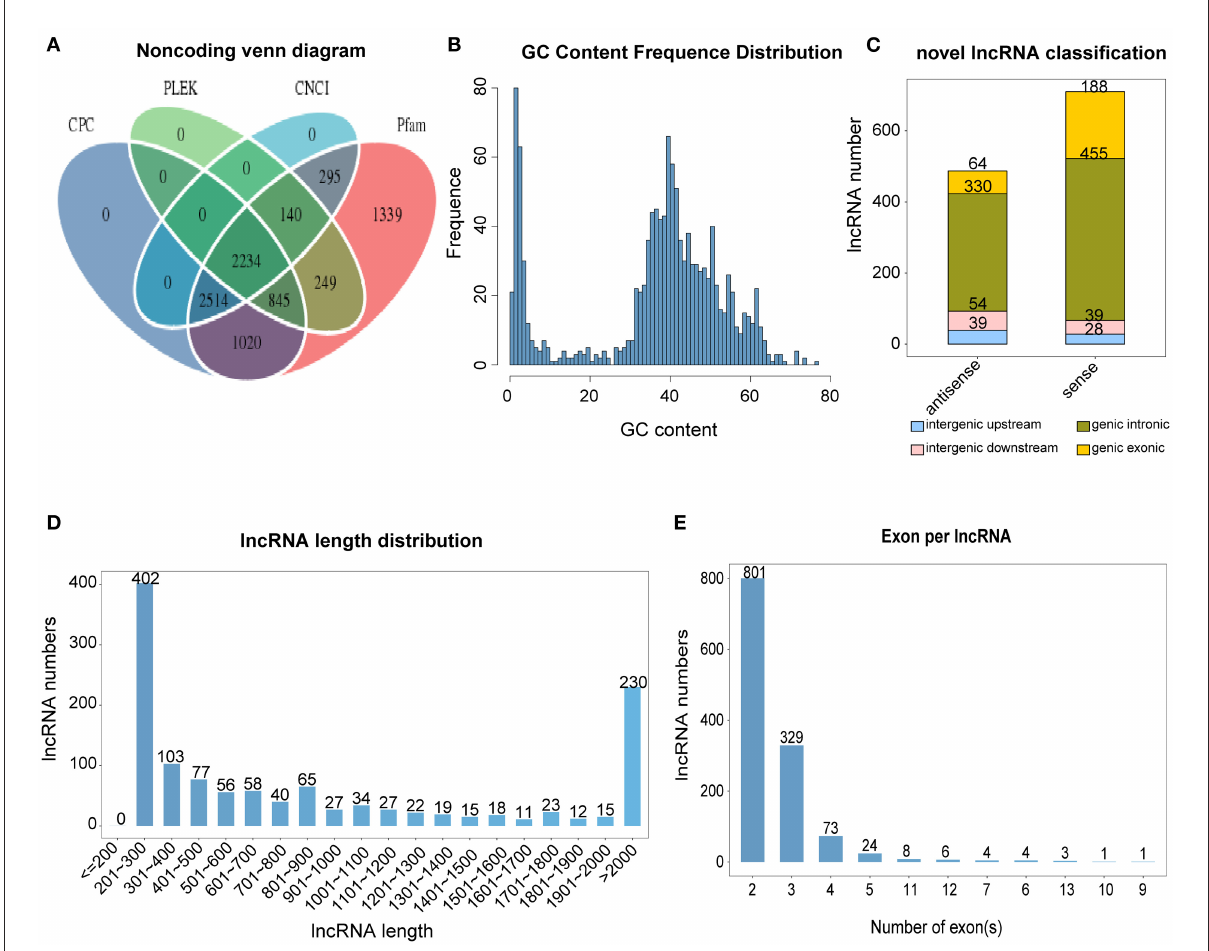
FIGURE2 Classification and identification of lncRNAs. (A) Venn diagram of lncRNA, predicted using CPC (Coding Potential Calculator), CNCI (Coding-Non-Coding Index), CPAT (Coding Potential Assessment Tool), and Pfam (Protein families). (B) lncRNA GC content. (C) lncRNA classification. (D) lncRNA length. (E) lncRNA exon